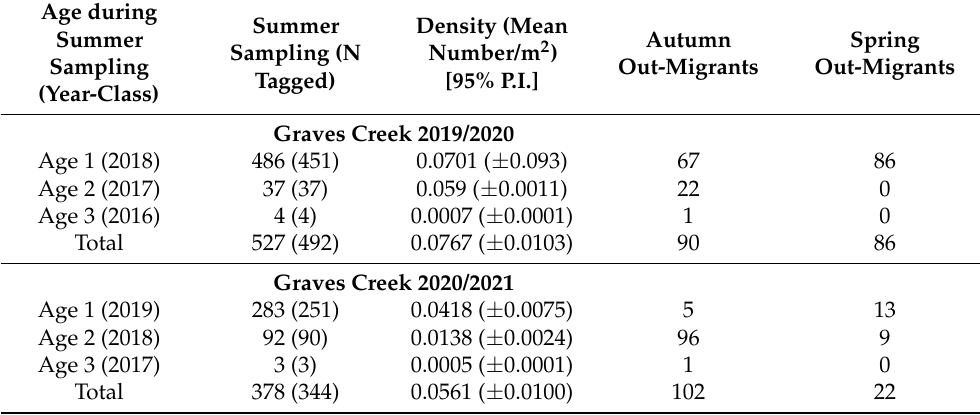
Table 2. Summary of the sample population of bull trout in Graves Creek, Montana, following elec- trofishing in the summer of 2019 and summer of 2020. Summer sampling numbers indicate the total number of bull trout sampled, with the number of tagged bull trout in parenthesis. Density is the mean overall density of each year-class during the summer sampling season. Autumn out-migrants are tagged bull trout that out-migrated during the autumn out-migration events in 2019 (4 Septem-